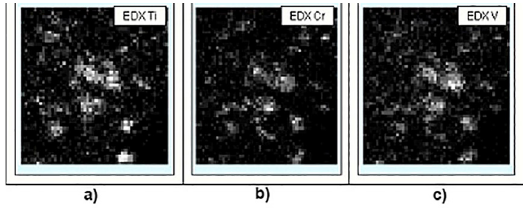
Figure 6. X-ray mapping of the additive elements: (a) Ti; (b) Cr; (c) V for the nanocomposite containing 5 mol% TiCrV. Scanning area of 100 x